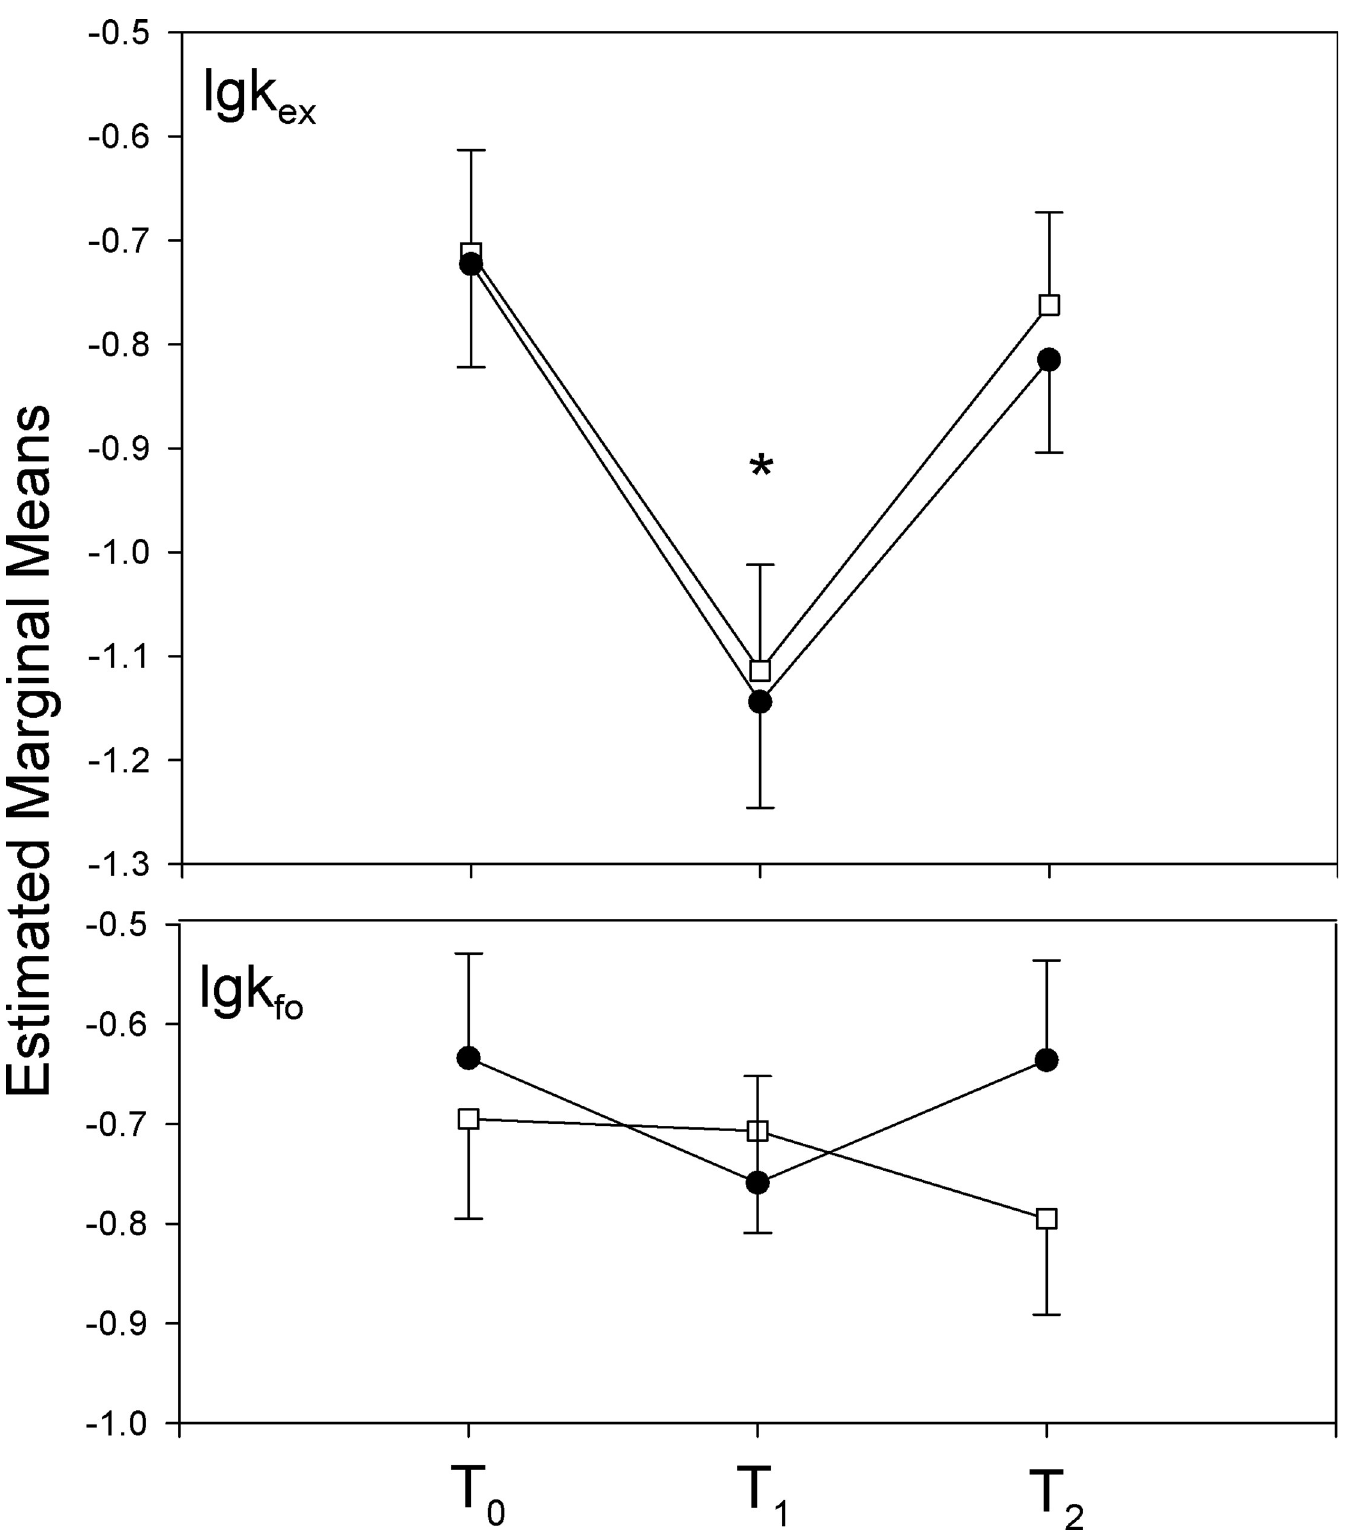
Fig 2. Log-transformed speed, Heart Rate (HR), and Rate of Perceived Exertion (RPE) change over the three time points; baseline (T 0) - post-training (T 1 ) and follow up (T 2 ) for training (TR) and Conditioning Training (COTR) groups. Open boxes COTR; closed boxes TR. � Significant effect of training, p < 0.05; #significant